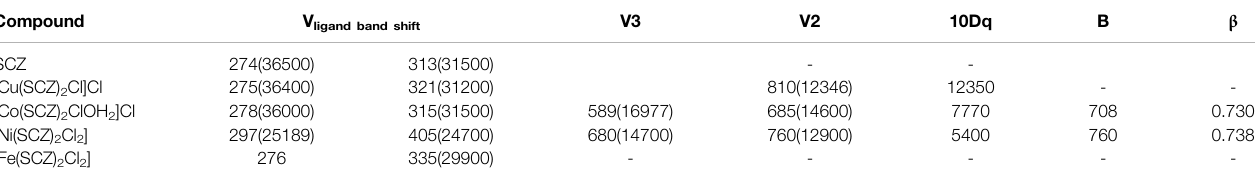
TABLE 2 | Electronic parameters of the metal complexes.